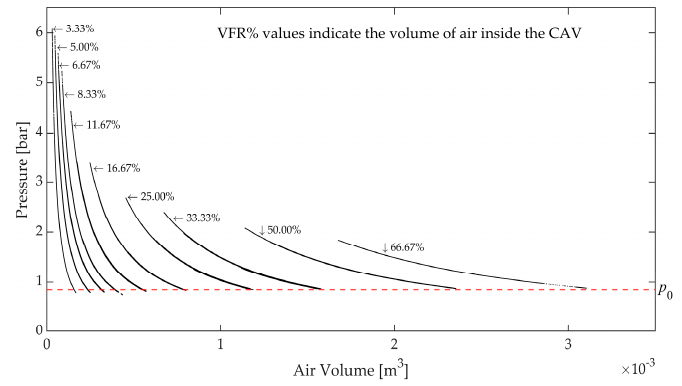
Figure 4. The pressure–volume diagram.